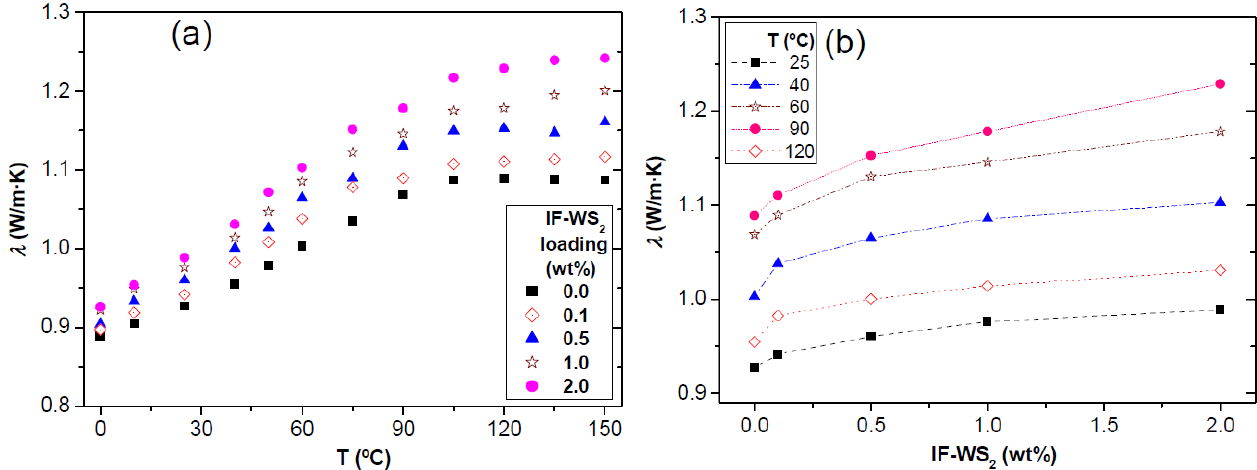
nanoparticle loading for different 2